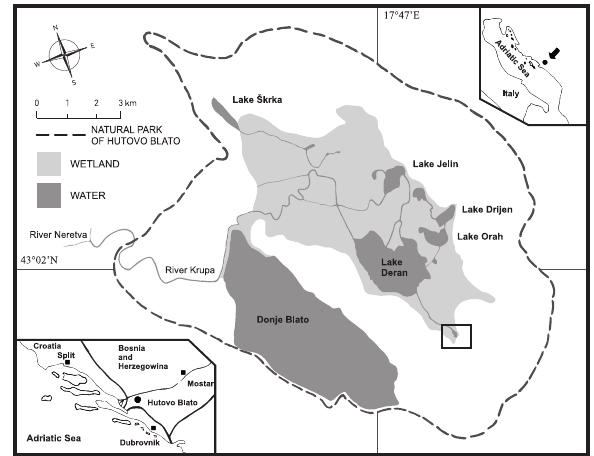
Fig. 3. The Neretva nase, Chondrostoma knerii , population in Hutovo Blato wetland spawn exclusively in springs around Londža spring area (black rectangle)